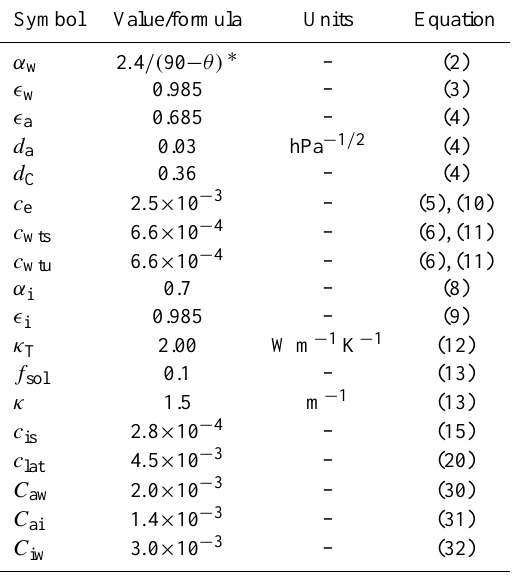
Table 1. Adjustable coefficients of the sea-ice model and their cali- brated